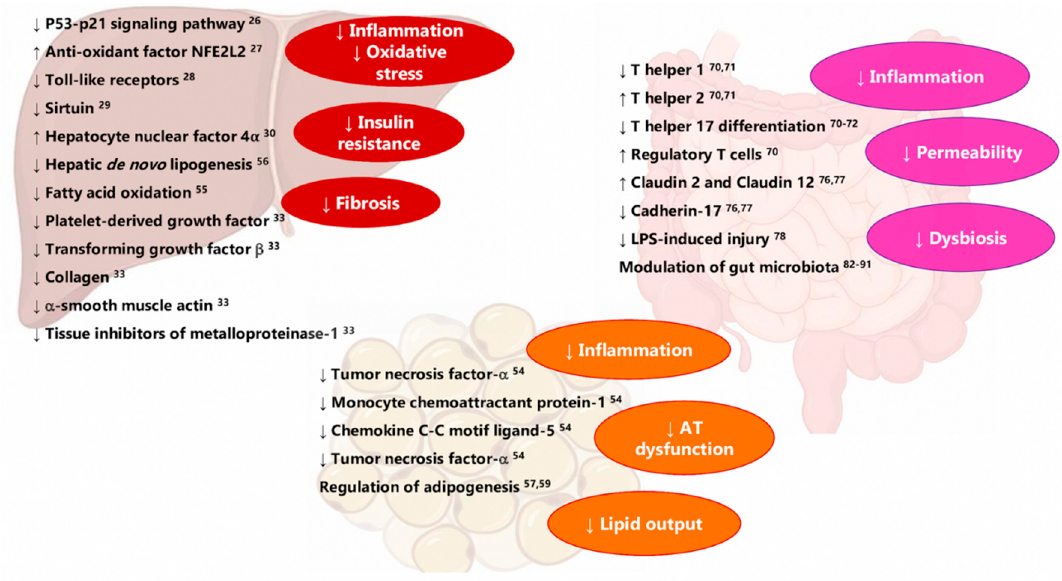
Figure 1. Potential pathways linking vitamin D / vitamin D receptor (VDR) axis to Metabolic dysfunction-Associated Fatty Liver Disease (MAFLD). AT—adipose tissue; ↑ —increase; ↓ —decrease. Vitamin D and liver